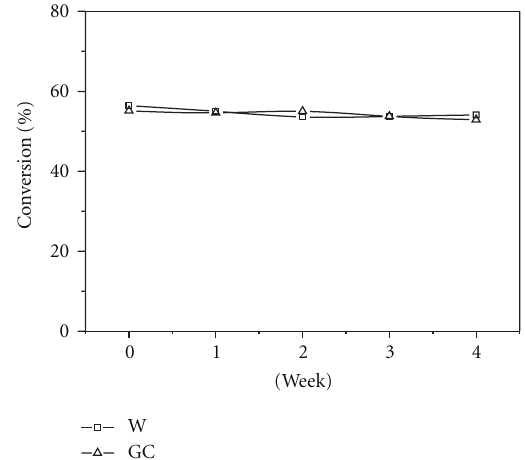
Figure 2: Storage stability of CALB in water and GC. Reaction conditions: Lipase powder (1.2mg); 500 μ L of solvent; 110 μ L of ethyl butyrate (0.83 mmol); 110 μ L of 1-butanol (1.21 mmol); stirring speed = 300 rpm; temperature = 40 ◦ C. Conversions refer to ethyl